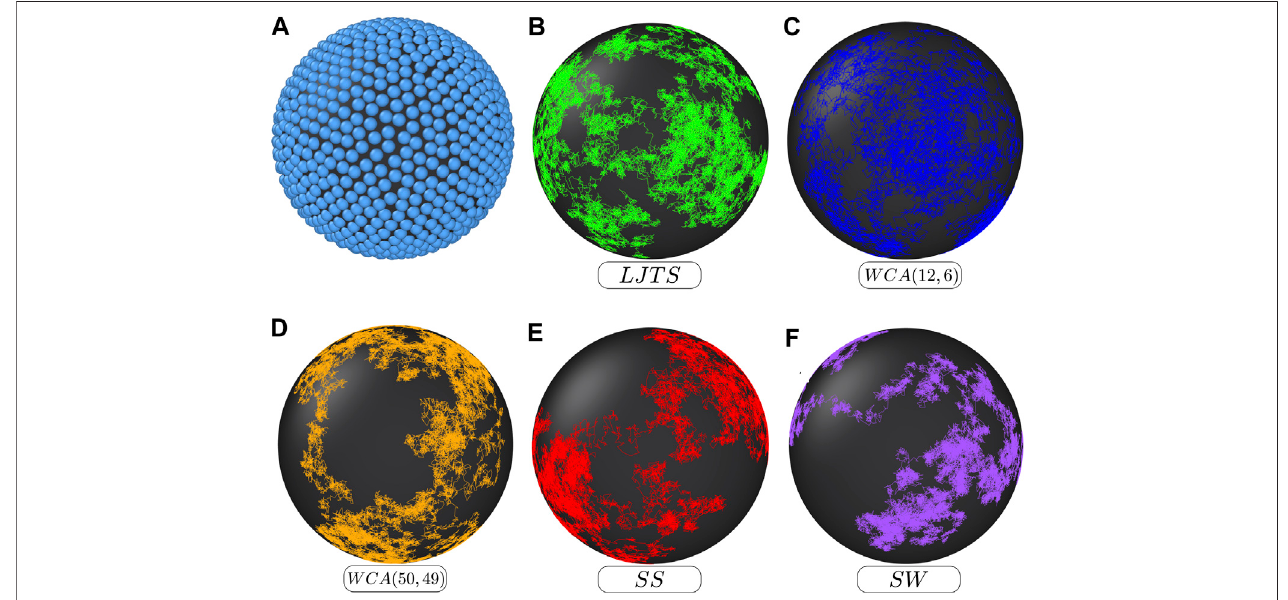
FIGURE 2 | (A) Representative instantaneous con fi guration of the system with N (cid:1) 1,000 particles on the spherical surface of density ρ p ((cid:1) N / A ) (cid:1) 0 . 92 and with a radius of R (cid:1) 9 . 3 σ . (B – F) Path of a tracer particle over the spherical surface for the different interaction potentials.